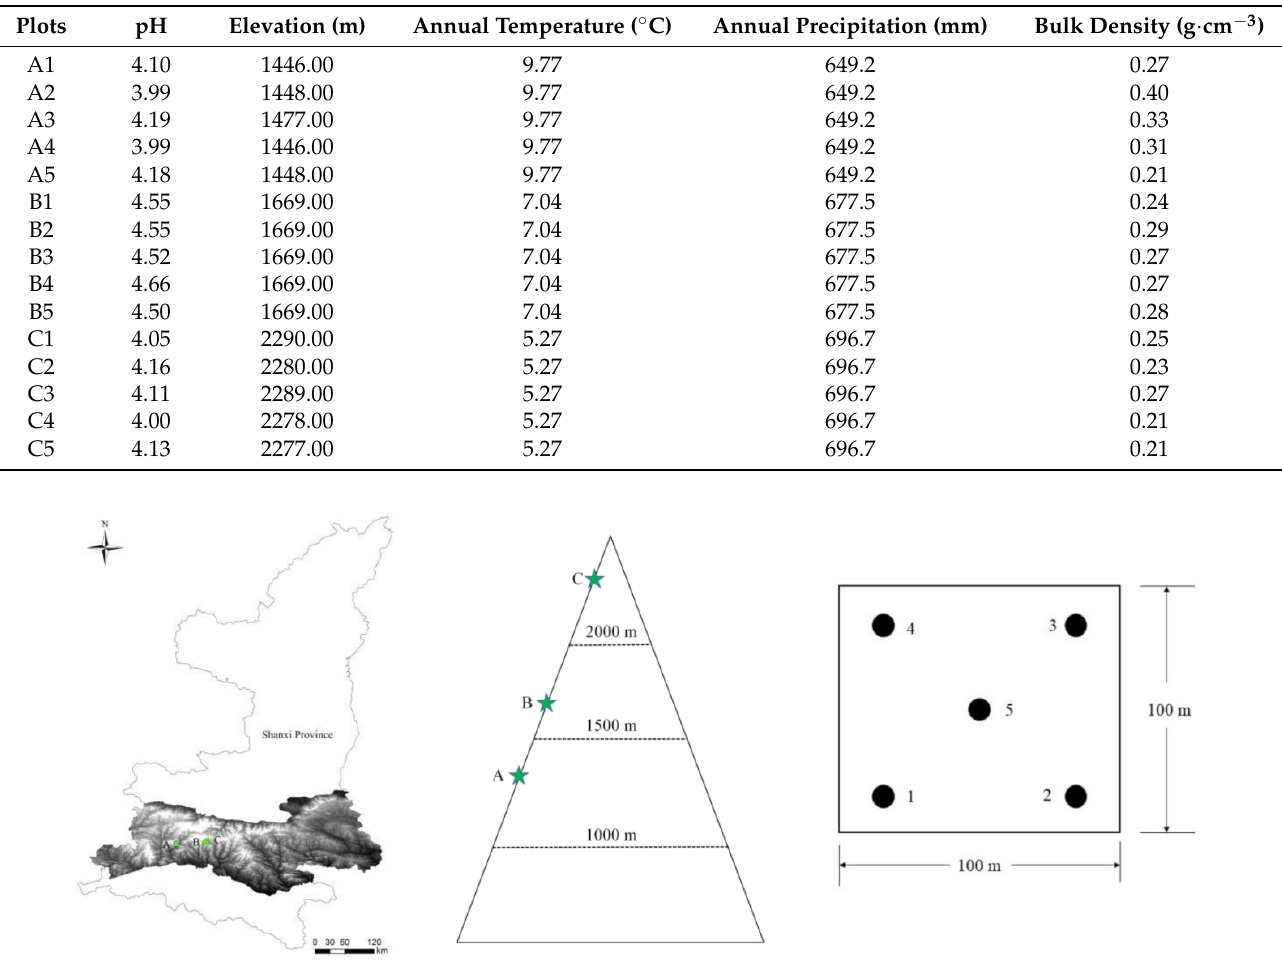
Figure 1. Locations of the three sampling sites and sampling